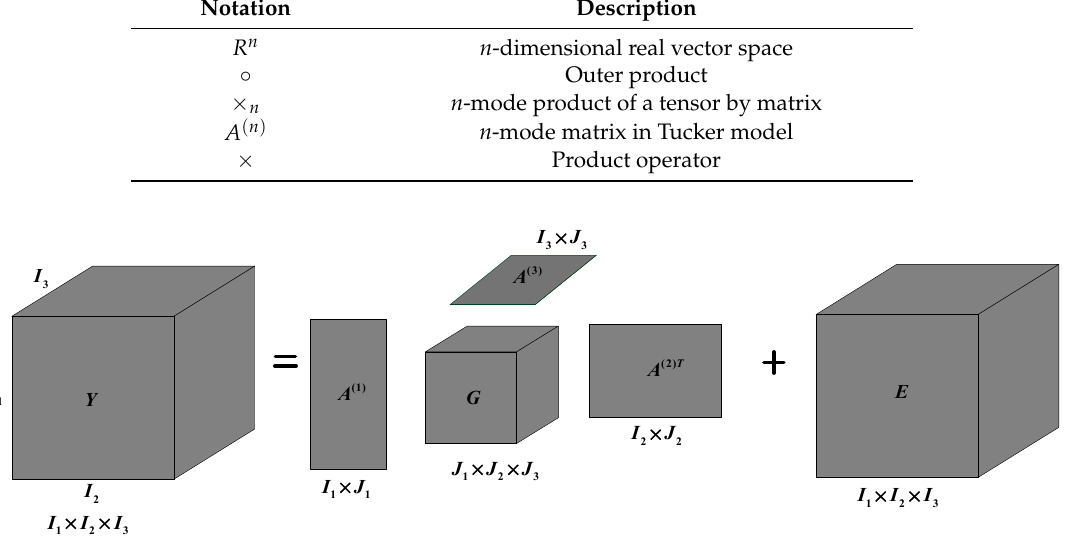
Figure 2 . A graphic representation of Tucker Decomposition on a three-dimensional tensor. Figure 2. A graphic representation of Tucker Decomposition on a three-dimensional To achieve Equation (1), the Tucker decomposition is a search process for the optimal core tensor and factor matrixes to make the minimized residual error tensor.